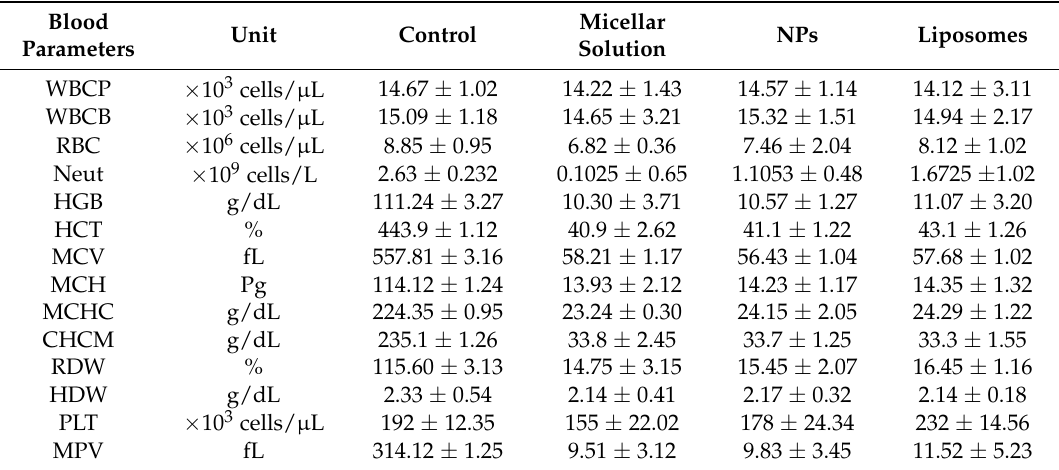
Table 1. Hematological screening for different formulations of CBZ on the fourth day (data as mean ± SE, n = 5).